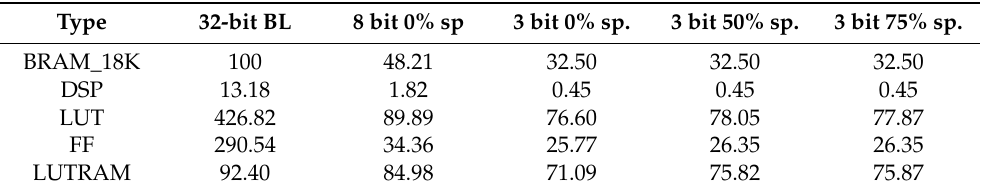
Table 5. Resource consumption (% of available resources of the Zynq Z-7020 FPGA) of the CNN1D designs with maximal reuse factor, % sp. stands for percentage of sparsity. Type 32-bit BL 8 bit 0% sp 3 bit 0% sp. 3 bit 50% sp. 3 bit 75%